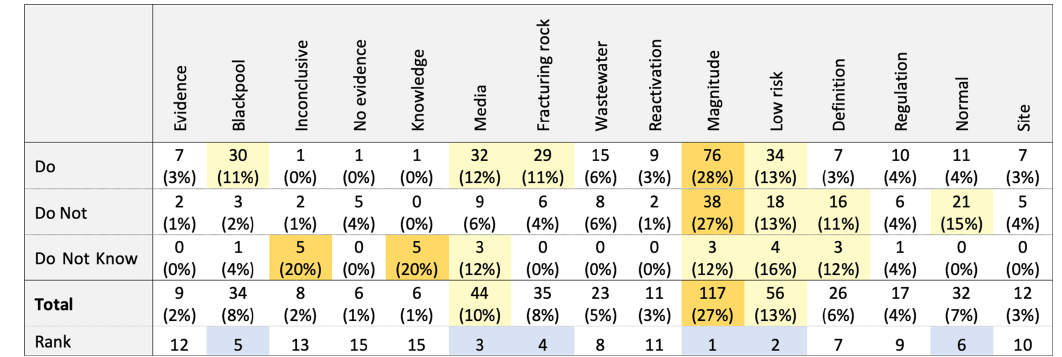
Table 5. The frequency of use of different thematic codes in the reasoning provided for participants’ answers, showing total number of times the code was applied and, in parentheses, the percentage relative to the number of responses in that category (“do”, “do not”, and “do not know”). High-frequency codes are coloured pale yellow ( ≥ 10%) and yellow ( ≥ 20%), respectively. For each one answer (reasoning) there could be more than one code. In the final row, codes are ranked for frequency, and the six codes that occur over 30 times are coloured in blue. These themes are examined in detail in Table 6.